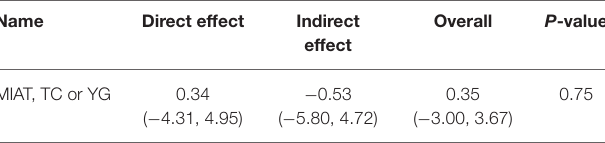
TABLE 5 | The results of the node splitting